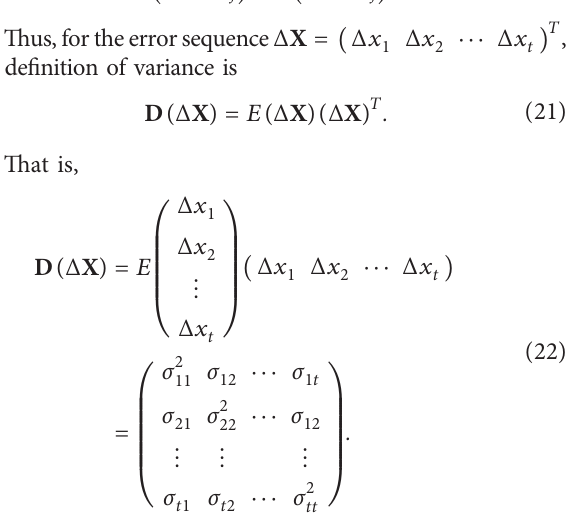
Figure 4: Regularity and randomness of rounding